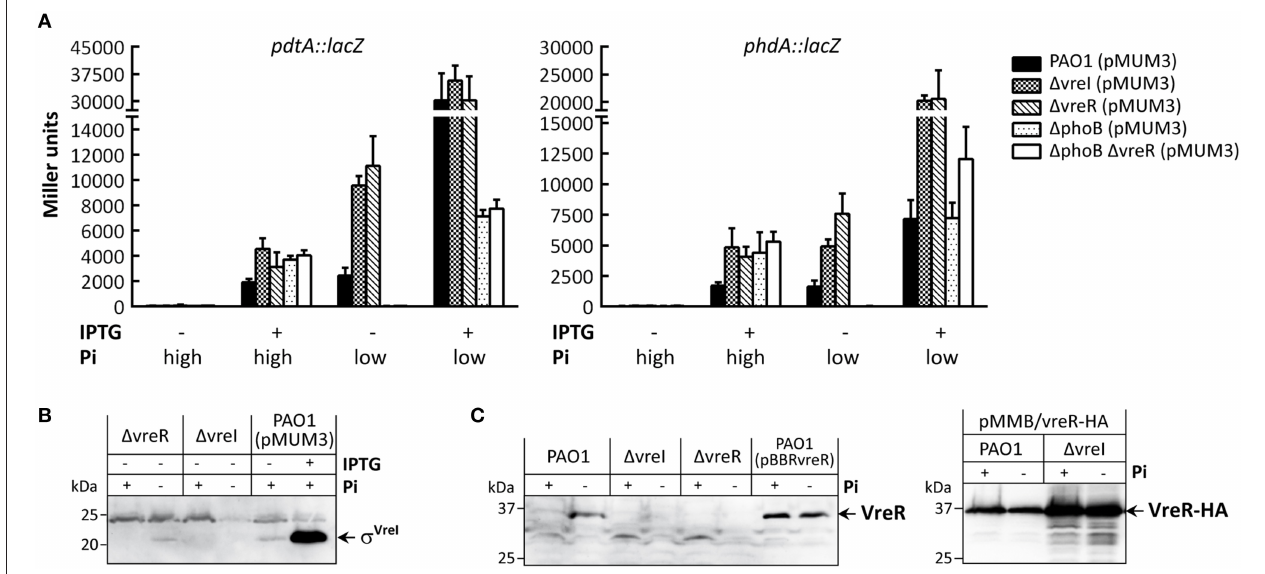
FIGURE 3 | Effect of σ VreI overproduction in the expression of the PUMA3 regulon. The indicated P. aeruginosa strains were grown 18h under high ( + ) or low Pi ( − ) conditions without ( − ) or with ( + ) 1mM IPTG. (A) β -galactosidase activity of P. aeruginosa strains bearing the indicated lacZ fusion and the pMUM3 plasmid expressing the vreI gene from the IPTG-inducible promoter P tac ( Llamas et al., 2009) ( Table 1 ). (B) Detection of σ VreI by Western-blot using a polyclonal anti-VreI antibody. The positions of the molecular size marker (in kDa) and the σ VreI protein are shown. (C) Detection of VreR by Western-blot using a polyclonal anti-VreR antibody (left panel) or a monoclonal anti-HA antibody (right panel). The production of the VreR-HA protein from plasmid ( Table 1 ) was induced with 1 mM IPTG. The positions of the molecular size marker (in kDa) and the VreR proteins are